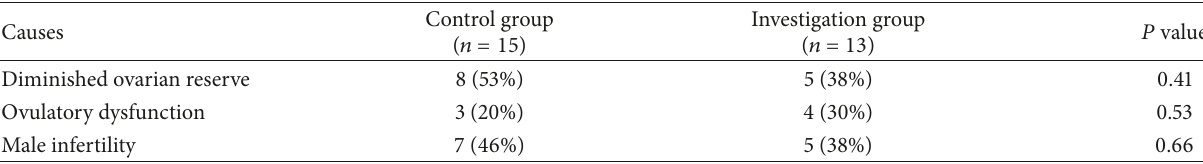
Table 2: Known causes of infertility in both groups.